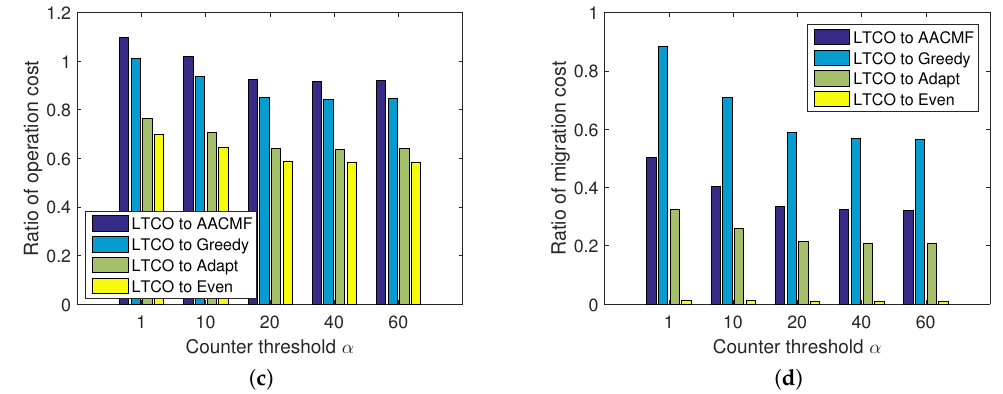
Figure 8. Impact of varied counter threshold α for real